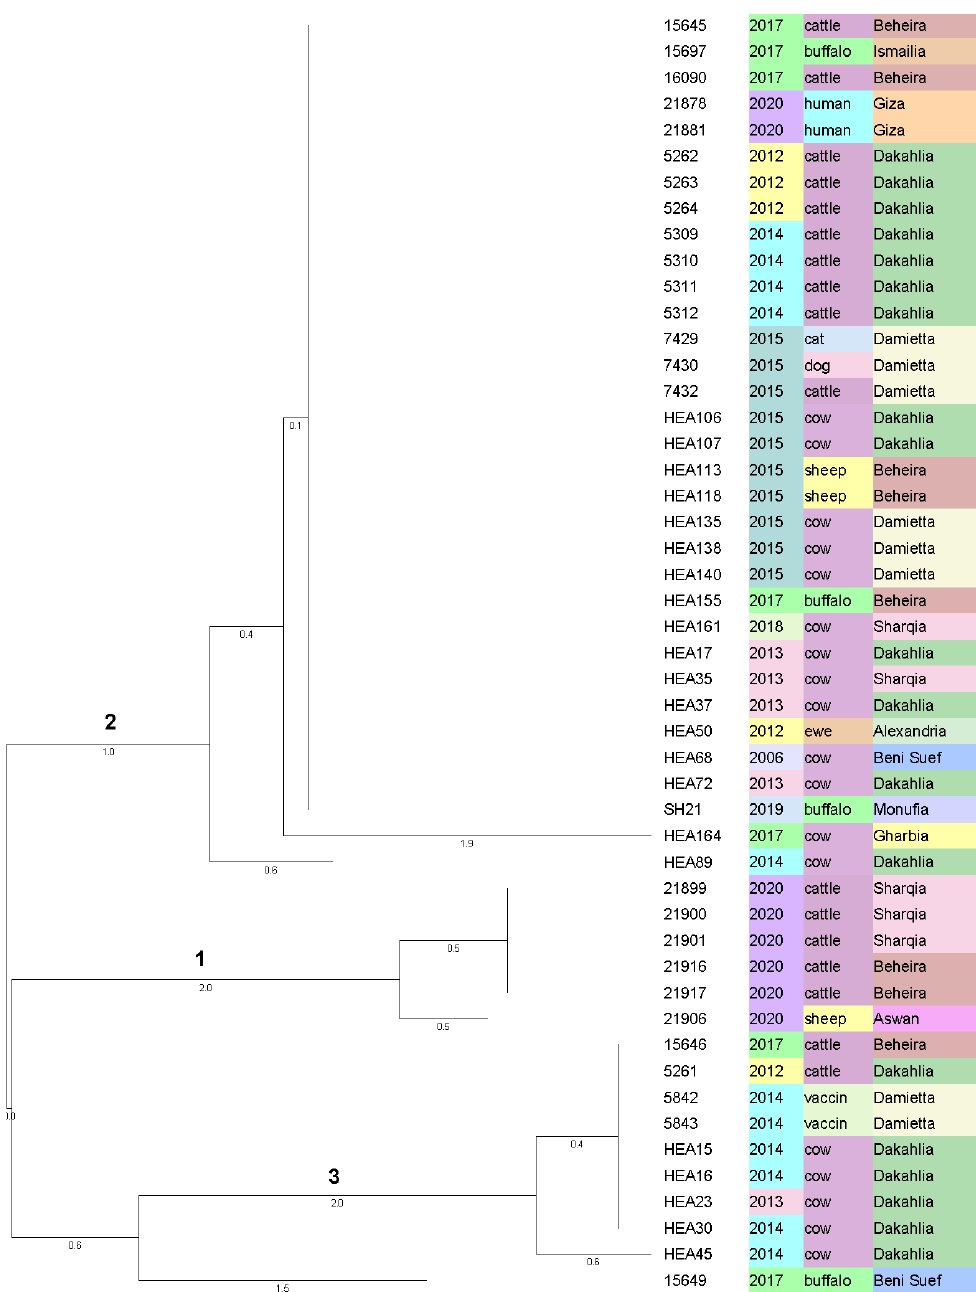
Figure 4. Neighbor-joining (NJ) tree for the 45 B. abortus field isolates plus two human isolates and two vaccine batches. The tree is based on MLVA-16 data from MISTReSS (https://github.com/Papos92/MISTReSS, accessed on 24 April 2021), calculated in Bionumerics using categorical values with 1000 permutations to receive the highest resampling support. The root position was set as the maximum branch length. The three columns represent the year of isolation, the host and the governorate, correspondingly.